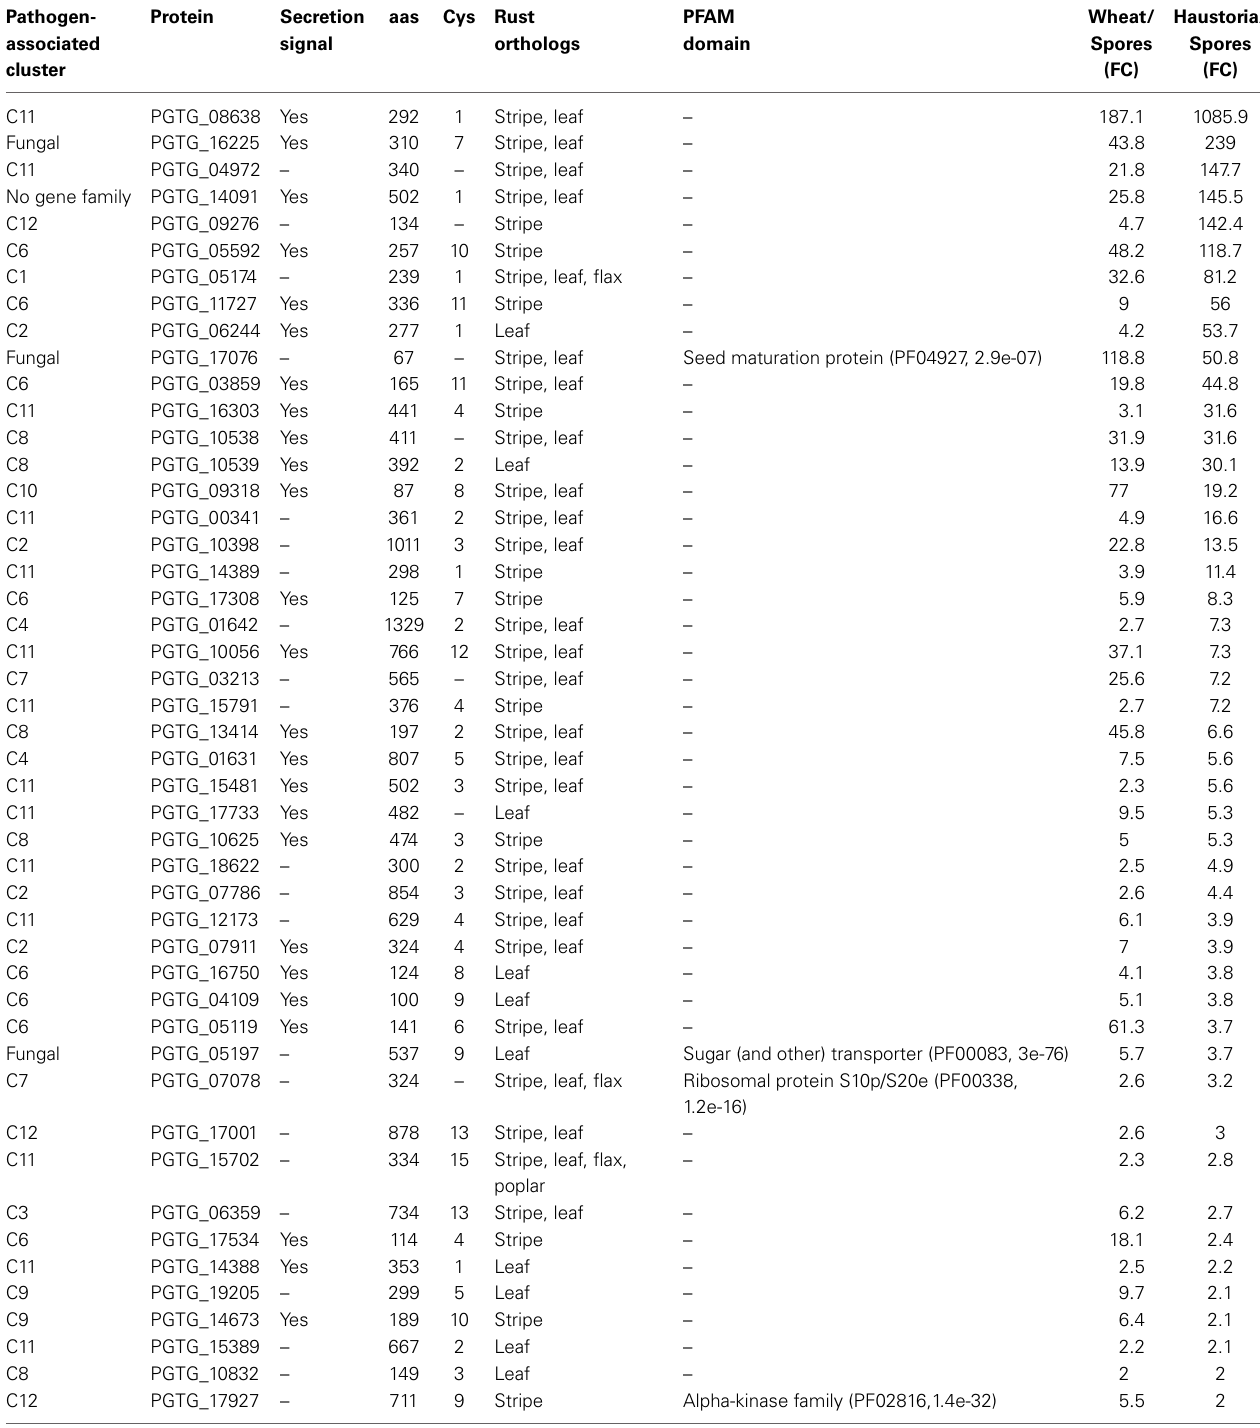
Table 4 | P. graminis f. sp. tritici genes that are predicted to undergo site-specific diversifying selection with significant in planta up-regulation (wheat infection to germinated urediniospores, p < 0 . 05, fold change > 2) and a fold change > 2 when comparing isolated haustoria to germinated